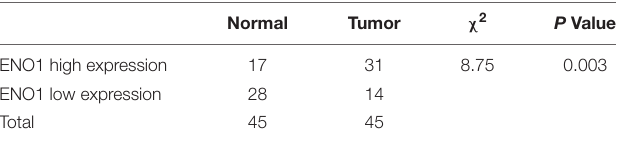
TABLE 1 | The expression of ENO1 in Normal tissue and thyroid carcinoma by IHC. Normal